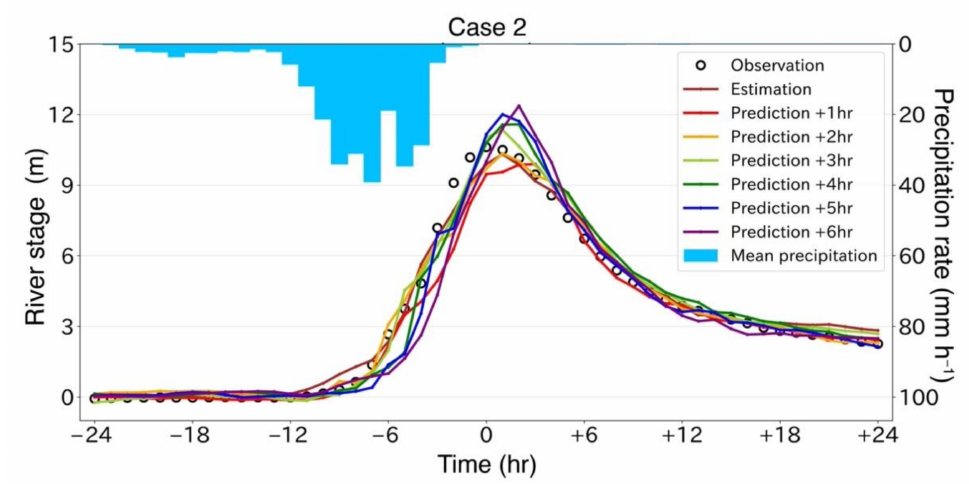
Figure 8. Case 2 observations and model runs. River stage is indicated by the left axis, precipitation by the right axis.